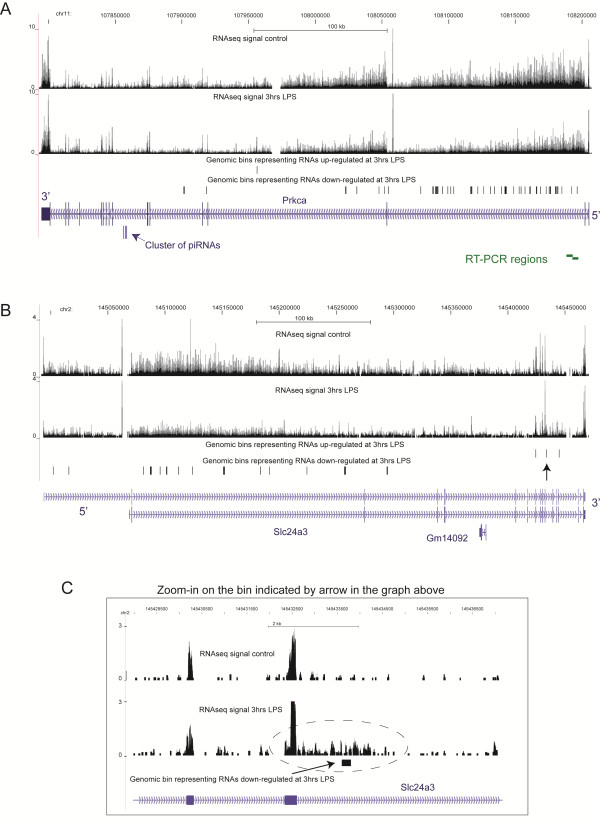
Examples of intronic RNAs downregulated at 3 hrs LPS with no changes in the exonic RNAs. The panel (C) shows zoom-in around the DE bin marked with an arrow in the panel (B). More details in the text. Positions of RT-PCR products presented in Figure
7 are shown (see Additional file
4 Table S3 for more details).